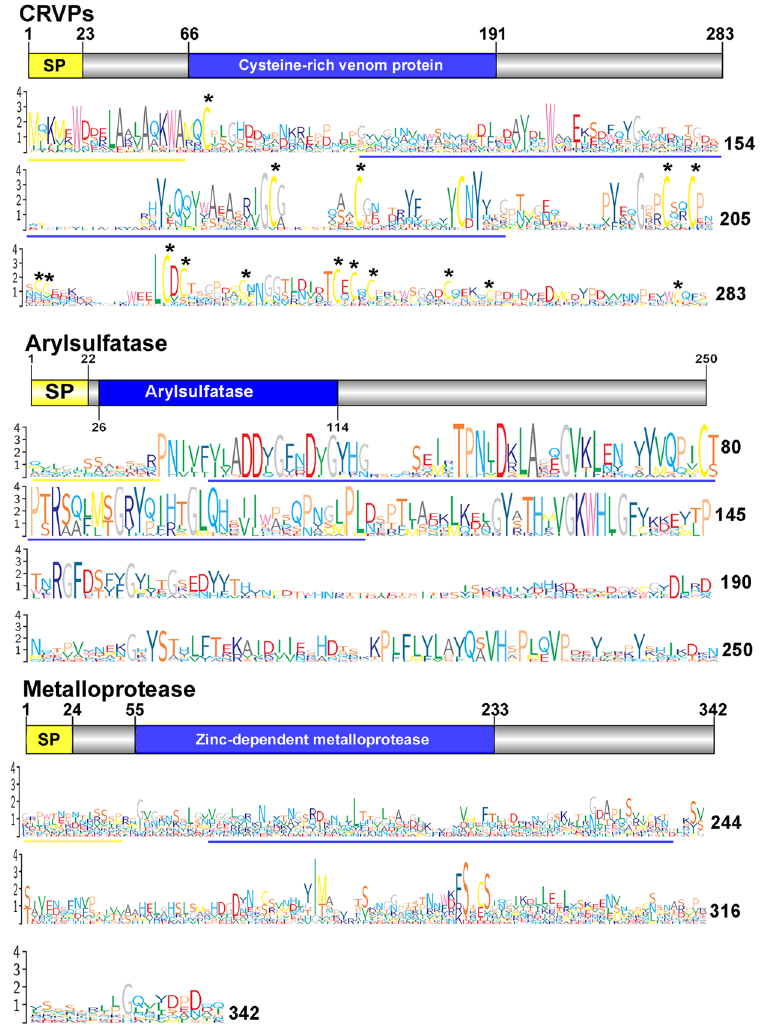
Figure 4. Molecular characterisation of Charonia tritonis cysteine-rich venom proteins (CRVPs), arylsulfatase and metalloprotease. Schematic diagram (top) showing the general organization with signal peptide (SP) and conserved domains (blue). Sequence logo representation (below) of multiple sequence alignments for C. tritonis with other species (Supplementary Data S8). Asterisks represent site of conserved cysteine (C) residues. Region of signal peptide (yellow) and conserved domain (blue) are shown.